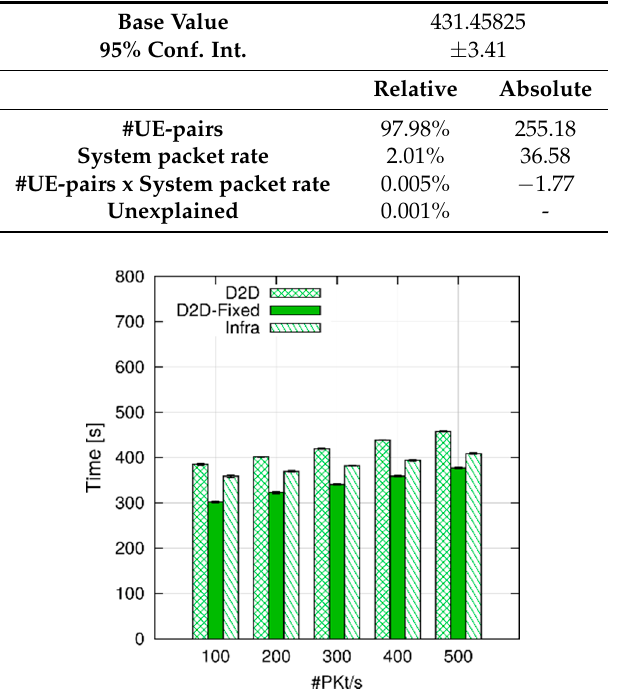
Figure 18. Execution time for an increasing system packet rate, obtained with a fixed number of 30 UEs.